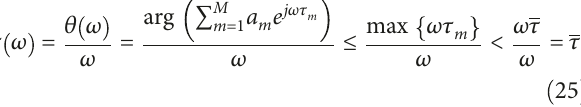
up with respect to